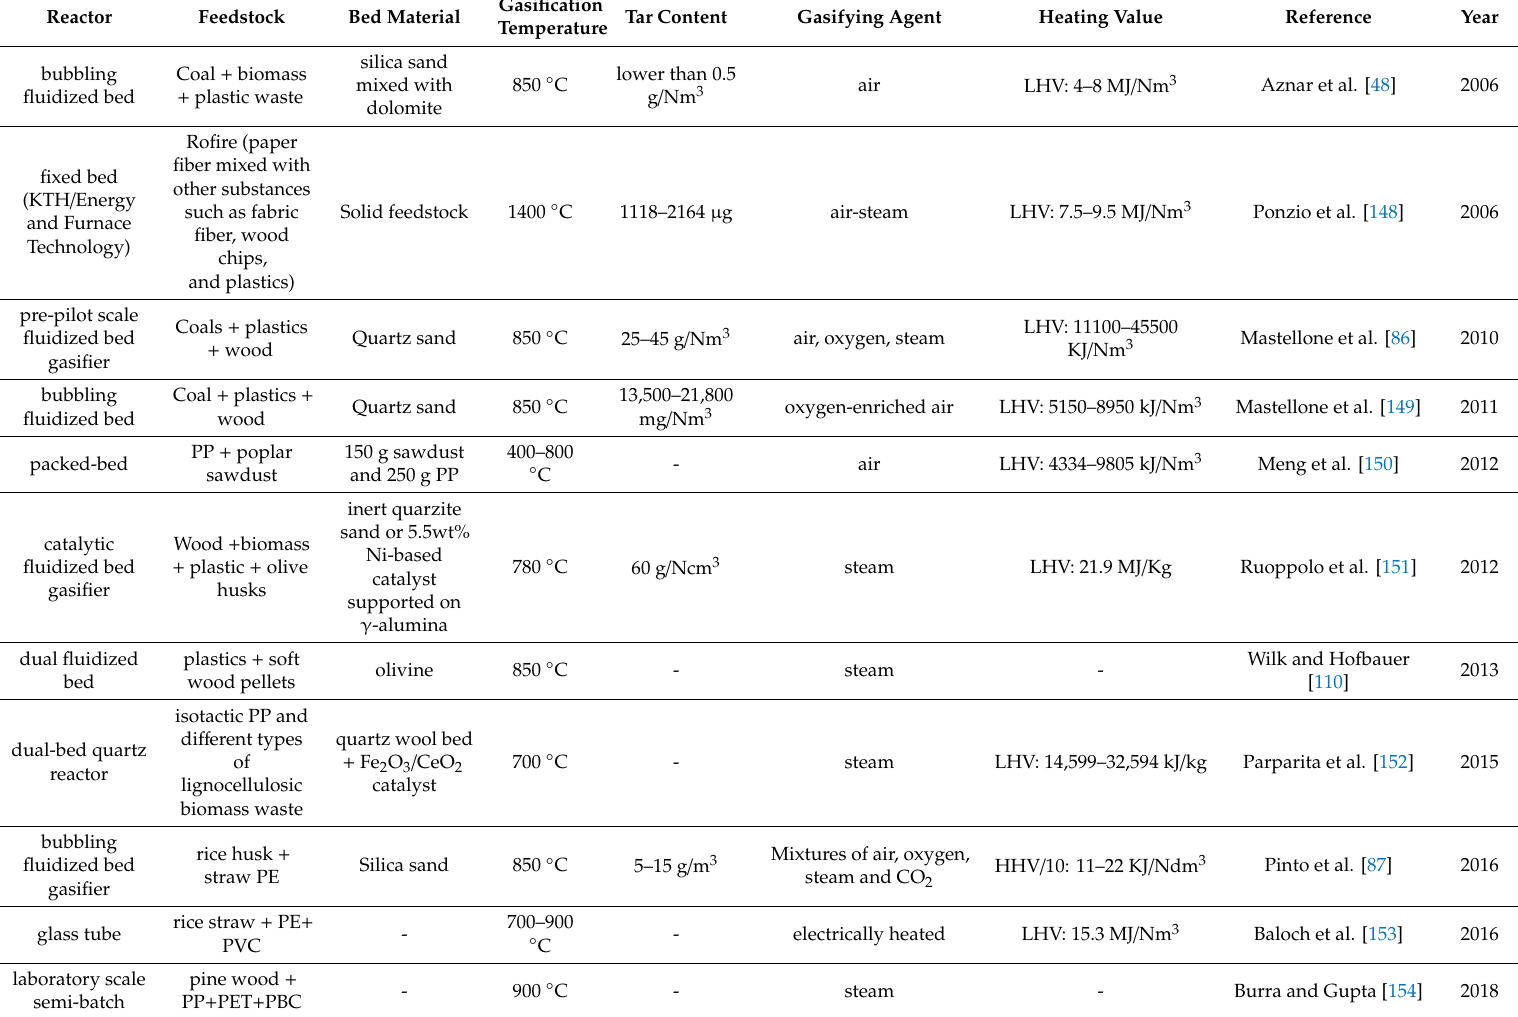
Table 7. Co-gasification summary